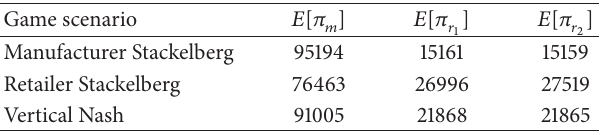
Table 2: Optimal expected profits of the manufacturer and the two